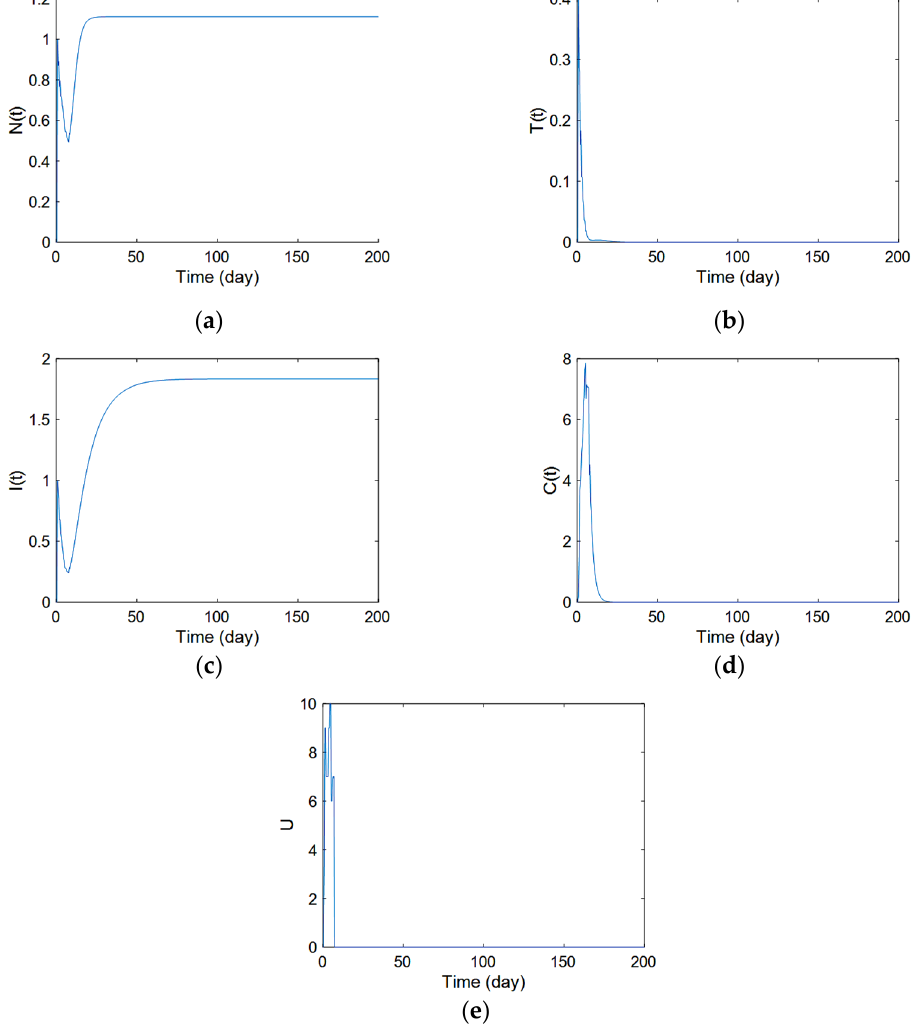
Figure 5. The result of simulation using the proposed control method for young patient with uncer- tainty. ( a ) Normal-cells ( b ) Tumor-cells ( c ) Immune-cells ( d ) Concentration of cells ( e ) Control ac- tion.